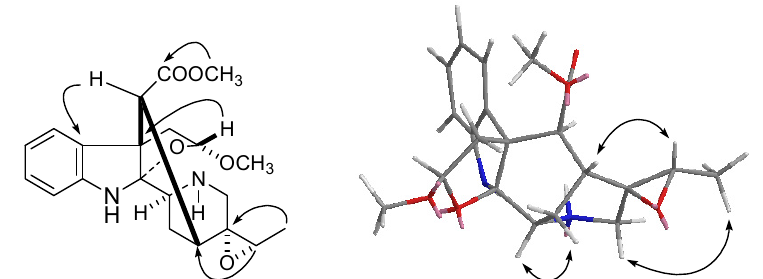
Figure 3. Key HMBC ( ) and NOESY ( ) correlations of of compound 4 .